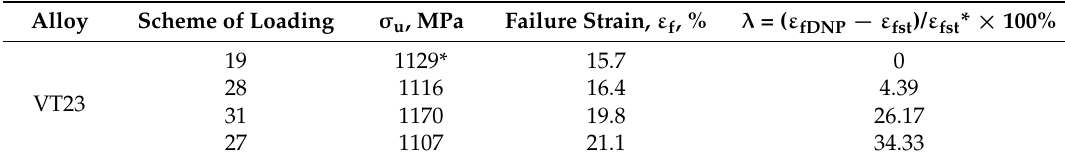
Table 4. Parameters of deformation and fracture of specimens from alloy VT23.